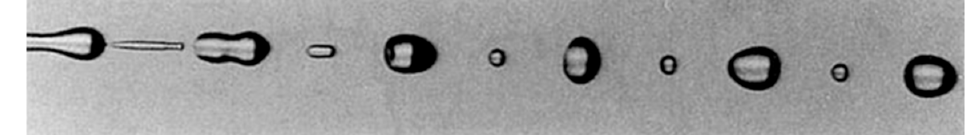
Figure 3. Instability of liquid jet with satellite drops; reproduced with permission from [36].